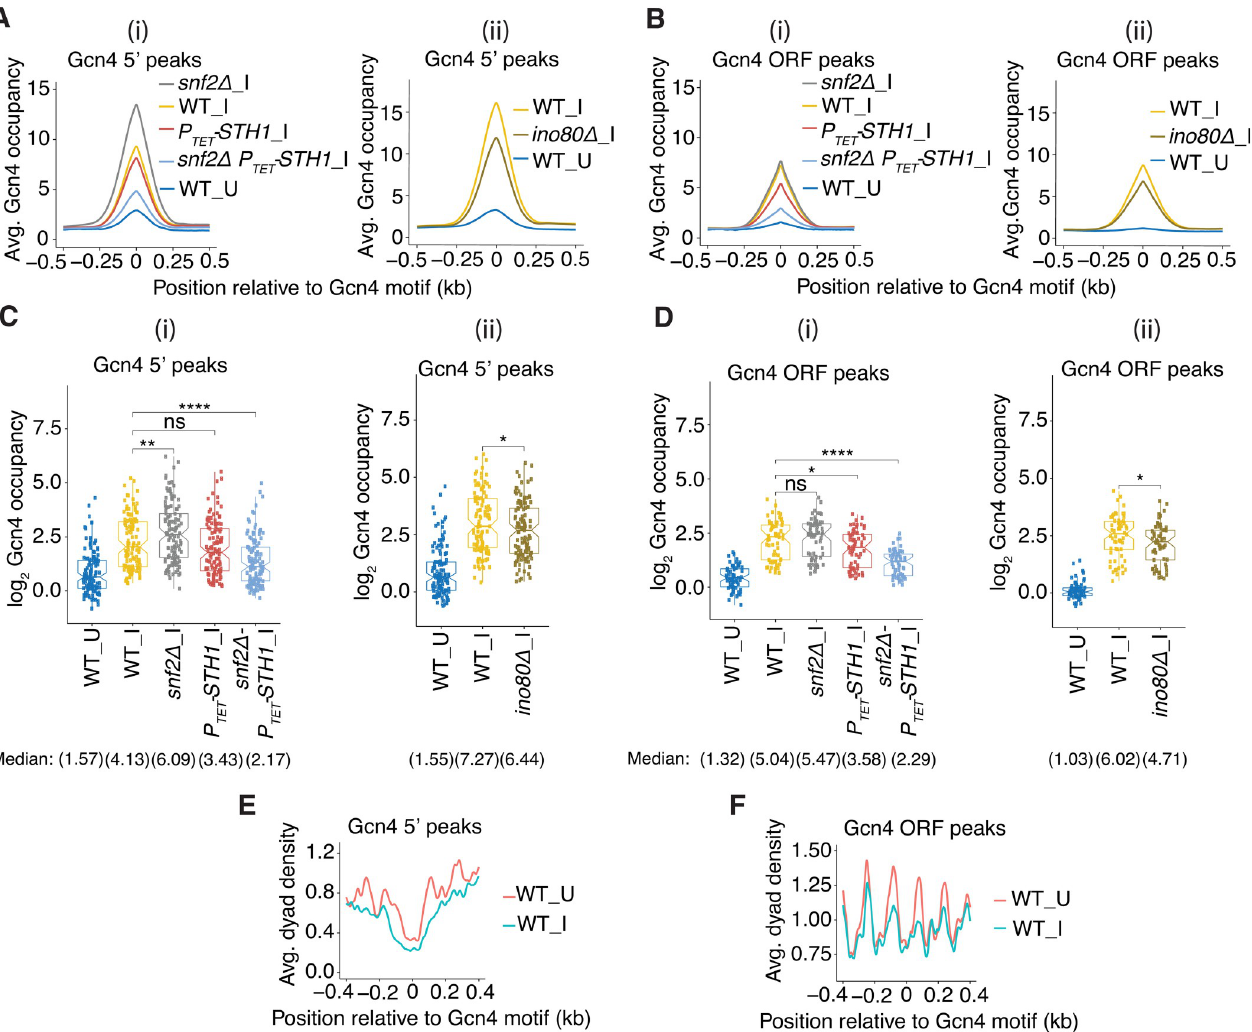
Fig 1. Gcn4 occupancy changes in CR mutants. (A-B) Gcn4 occupancies at each base pair surrounding the consensus binding motifs averaged over (A) all 117 5’ sites or (B) all 62 ORF Gcn4 peaks in WT_U (blue), WT_I (yellow), and SM-induced CR mutants for (i) snf2 Δ _I (gray), P TET -STH1_ I (red), snf2 Δ P TET - STH1_ I (cyan); and (ii) WT_I (yellow) and ino80 Δ _I (gold). In these and all similar plots below, yeast strain/condition labels adjacent to the tracings are listed in decreasing order of summit heights. ( C-D ) Notched box plots of log 2 Gcn4 occupancies per nucleotide averaged over the peak coordinates assigned by MACS2 analysis of (C) 5’ and (D) ORF Gcn4 peaks for (i) WT_U, WT_I, and CR mutants snf2 Δ _I, P I and snf2 Δ P I; and (ii) WT_U, TET -STH1_ TET -STH1_ WT_I, and ino80 Δ _I samples, color-coded as in (A-B). For these and all subsequent box plots, each box depicts the interquartile range containing 50% of the data, intersected by the median; the notch indicates a 95% confidence interval (CI) around the median, and p values for the significance of differences in median values calculated by the Mann-Whitney-Wilcoxon test are indicated as follows: ���� , � 0.0001; ��� , � 0.001; �� , � 0.01; � , � 0.05; ns, > 0.05. Unlogged median Gcn4 occupancies are indicated under the respective strain labels. Data analyzed in (A-D) were calculated from Gcn4 ChIP-seq analysis of sonicated chromatin from 2–4 biological replicates and normalized to the average occupancy per nucleotide on each chromosome for each data set. ( E-F ) Average dyad densities calculated from H3 MNase-ChIP-seq data aligned to the Gcn4 consensus motifs for (B) 5’ and (D) ORF Gcn4 peaks in WT cells either untreated (_U) or SM-treated (_I). Midpoints (dyads) of nucleosome-size sequences between 125 and 175 bp were mapped with respect to Gcn4 consensus motifs. Average profiles were smoothed using a moving average filter with a span of 31 bp. The data were normalized to the average occupancy per nucleotide on each chromosome for each data set. To explore further the contributions of the CRs at individual Gcn4 motifs, we sorted the 5’ Gcn4 peaks according to their reductions in Gcn4 occupancies in the snf2 Δ P -STH1 _I dou- TET ble mutant compared to WT_I cells. A heat map showing the differences in Gcn4 occupancies between the double mutant and WT for this ordering of 5’ sites is shown in Fig 2A(i), which